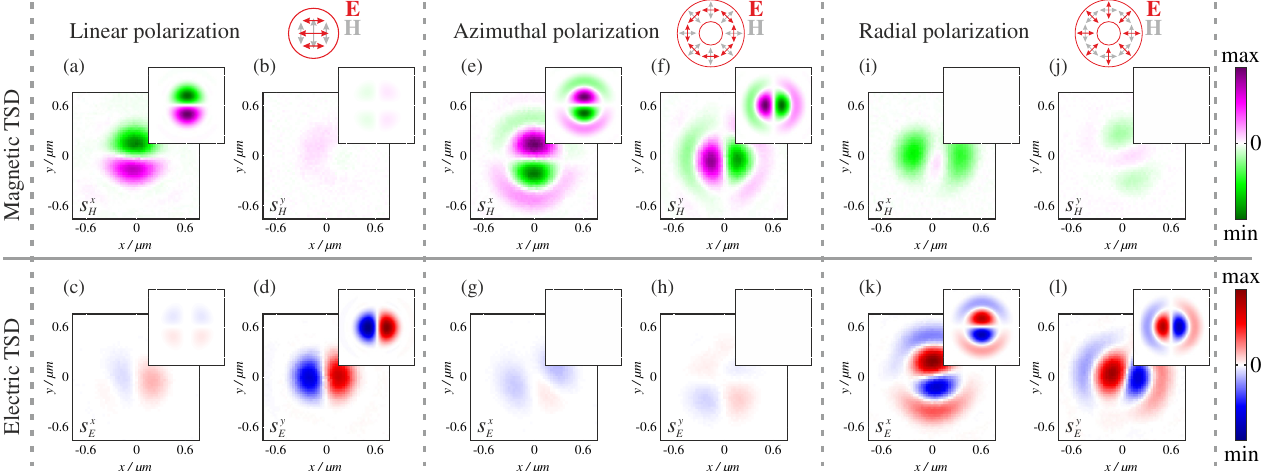
FIG. 4. Experimentally measured and theoretically calculated focal distributions of the magnetic and electric TSDs of tightly focused linearly, azimuthally, and radially polarized beams. The left column shows the TSD distributions of a tightly focused linearly polarized beam. Panels (a) and (b) depict the x and y components of s H , while panels (c) and (d) depict the x and y components of s E . Panels (e) – (h) display the corresponding distributions of a tightly focused azimuthally polarized beam (central column), and panels (i) – (l) present the corresponding distributions of a tightly focused radially polarized beam (right column). All distributions of the magnetic and the electric TSD are normalized to their common maximum value, respectively, in order to enable a direct comparison between all three